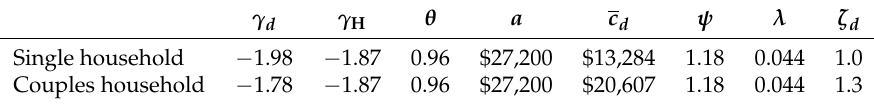
Table 2. Model parameters where monetary values have been adjusted for 2016. γ d γ H θ a c d ψ λ ζ d Single household − 1.98 − 1.87 0.96 $27,200 1.18 0.044 1.0 Couples household −